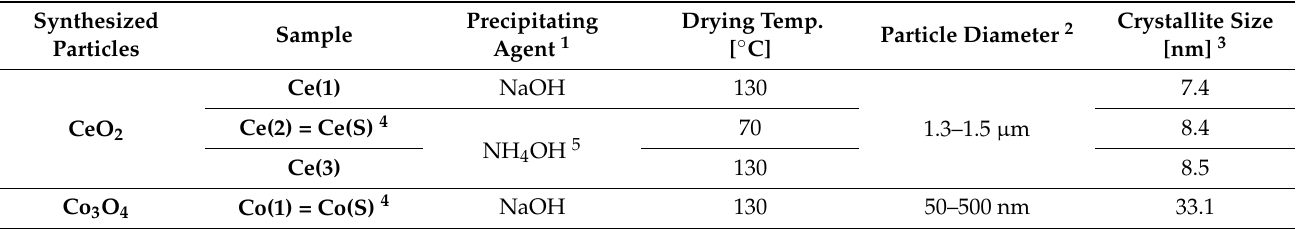
Table 1. Synthesized CeO 2 and Co 3 O 4 particles: preparation conditions and main features. All samples were calcined at 600 ◦